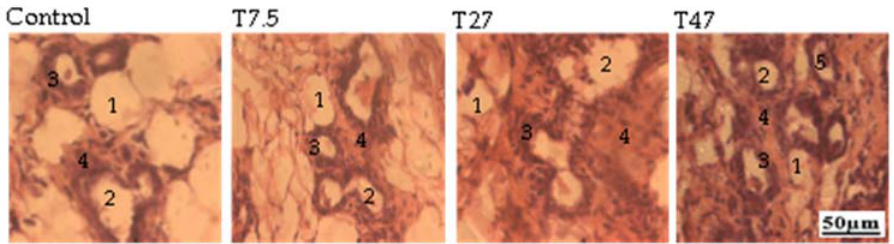
Figure 5. Microphotographs (25 × ) of hematoxylin/eosin-stained sections of mammary glands of immature female Wistar rats after 40 days of treatment. Control = animals receiving vehicle (distilled water, 10 mL/kg BW); T = rats treated with tartrazine at doses of 7.5; 27, and 47 mg/kg BW. 1 = Adipose tissue; 2 = Lumen of alveoli; 3 = Alveoli epithelium; 4 = Gland parenchyma; 5 = Eosinophilic secretion.